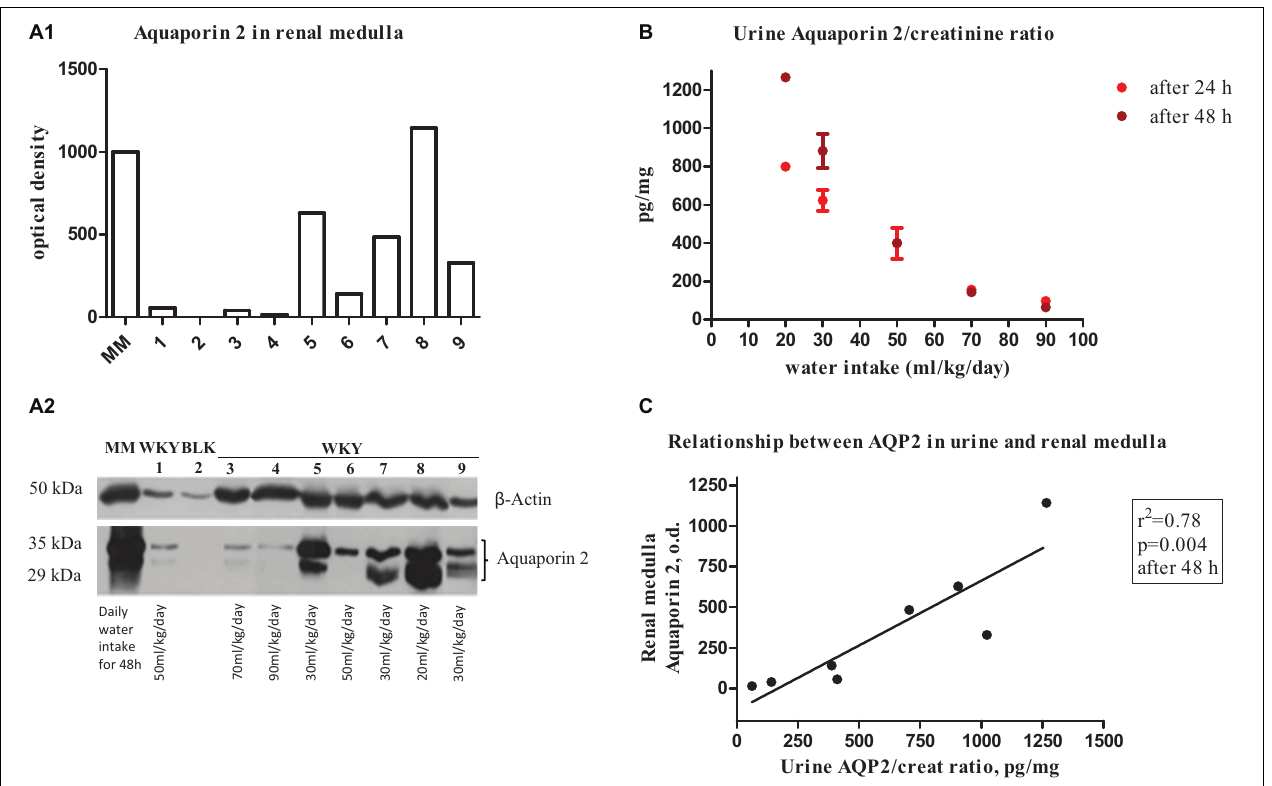
FIGURE 1 | (A1) Bar graphs show quantitative changes in renal medulla aquaporin 2 protein expression in young female WKY rat measured by optical densitometry of immunoblotting (below). Bars represent the sum of the optical densities of the two bands observed for aquaporin 2 water channel (lower and upper bands represent native and glycosylated aquaporin 2, respectively). (A2) Representative immunoblot of AQP2 in renal medulla of a female WKY. Blots were incubated with polyclonal anti-AQP2 and β -Actin antibodies. MM indicates molecular weight markers. Lane 1, 6: daily water intake of 50 ml/kg; lane 3: daily water intake of 70 ml/kg; lane 4: daily water intake of 90 ml/kg; lanes 5, 7, 9: daily water intake of 30 ml/kg; and lane 8: daily water intake of 20 ml/kg. BLK indicates blank without primary anti-AQP2 antibody. (B) Urine aquaporin 2/creatinine ratio at different water intake (from 20 ml/kg to 90 ml/kg at 24 h and 48 h). (C) Relationship between urine aquaporin 2/creatinine ratio and renal medulla aquaporin 2 protein expression in the young female WKY rat.